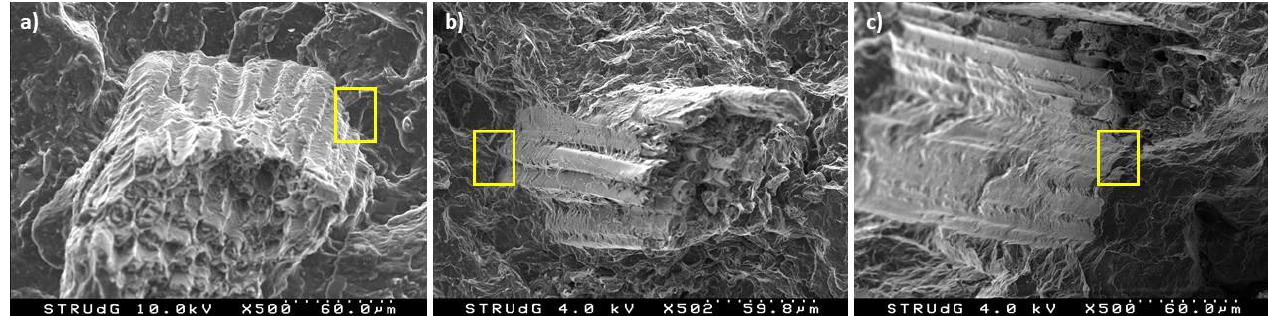
Figure 6. SEM micrograph of the flexural fractured surface for ( a ) mechanical pretreated date palm fibers; ( b ) chemical pretreated date palm fibers; ( c ) enzymatic pretreated date palm fibers.